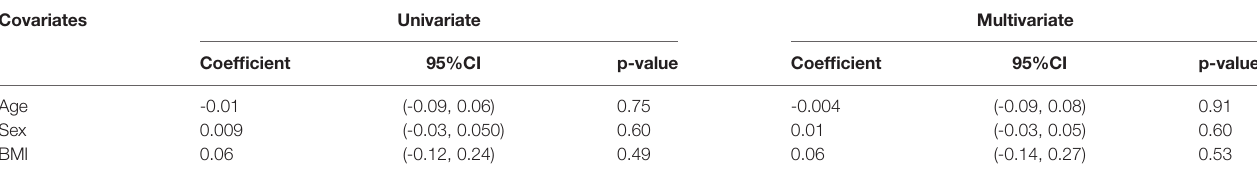
TABLE 3 | Meta-regression analysis for assessment of all glycemic abnormalities between primary aldosteronism and essential hypertension patients.